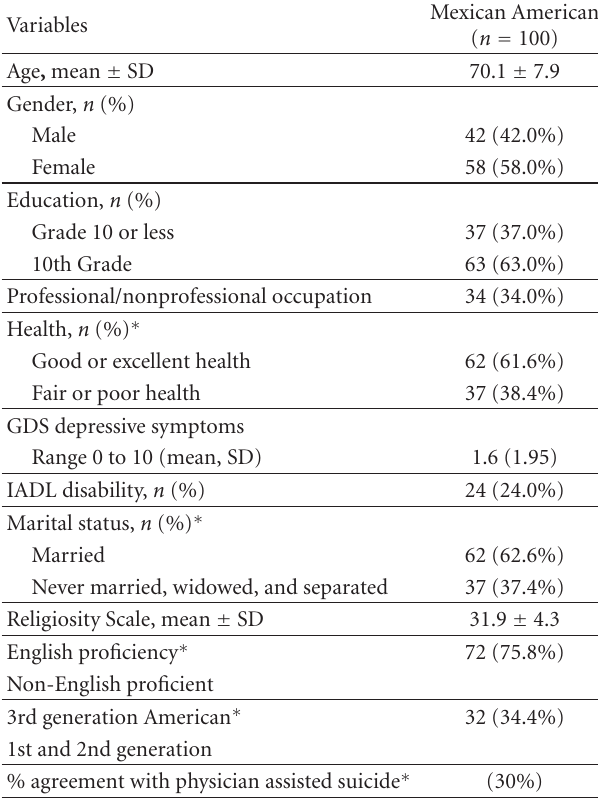
Table 1: Description of the community dwelling older Mexican American